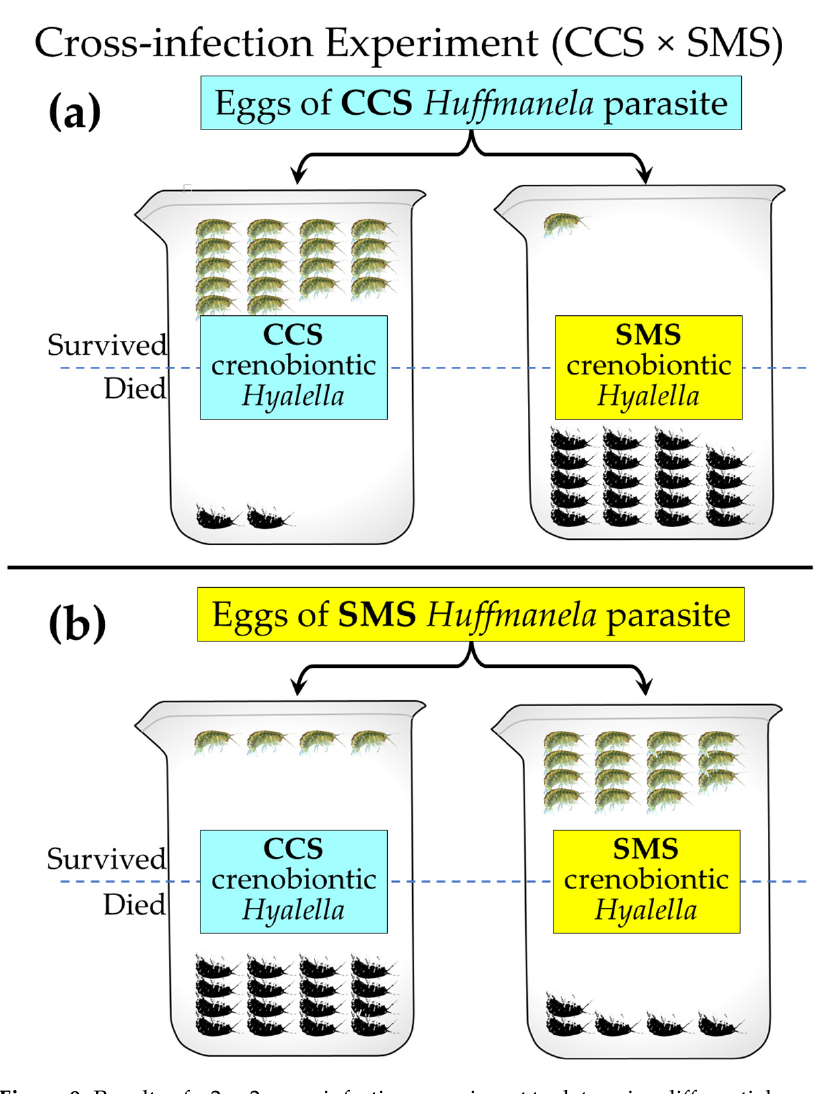
Figure 9. Results of a 2 × 2 cross-infection experiment to determine differential mortality rates of the two crenobiontic Hyalella clades when over exposed to eggs of Huffmanela clades from the local vs. the exotic springs. Panel (a) is exposure of Hyalellla to CCS Huffmanela while panel (b) is exposure to SMS Huffmanela . Table 5. Chi‑square contingency analysis of the data from the differential survivability experiment depicted in Figure